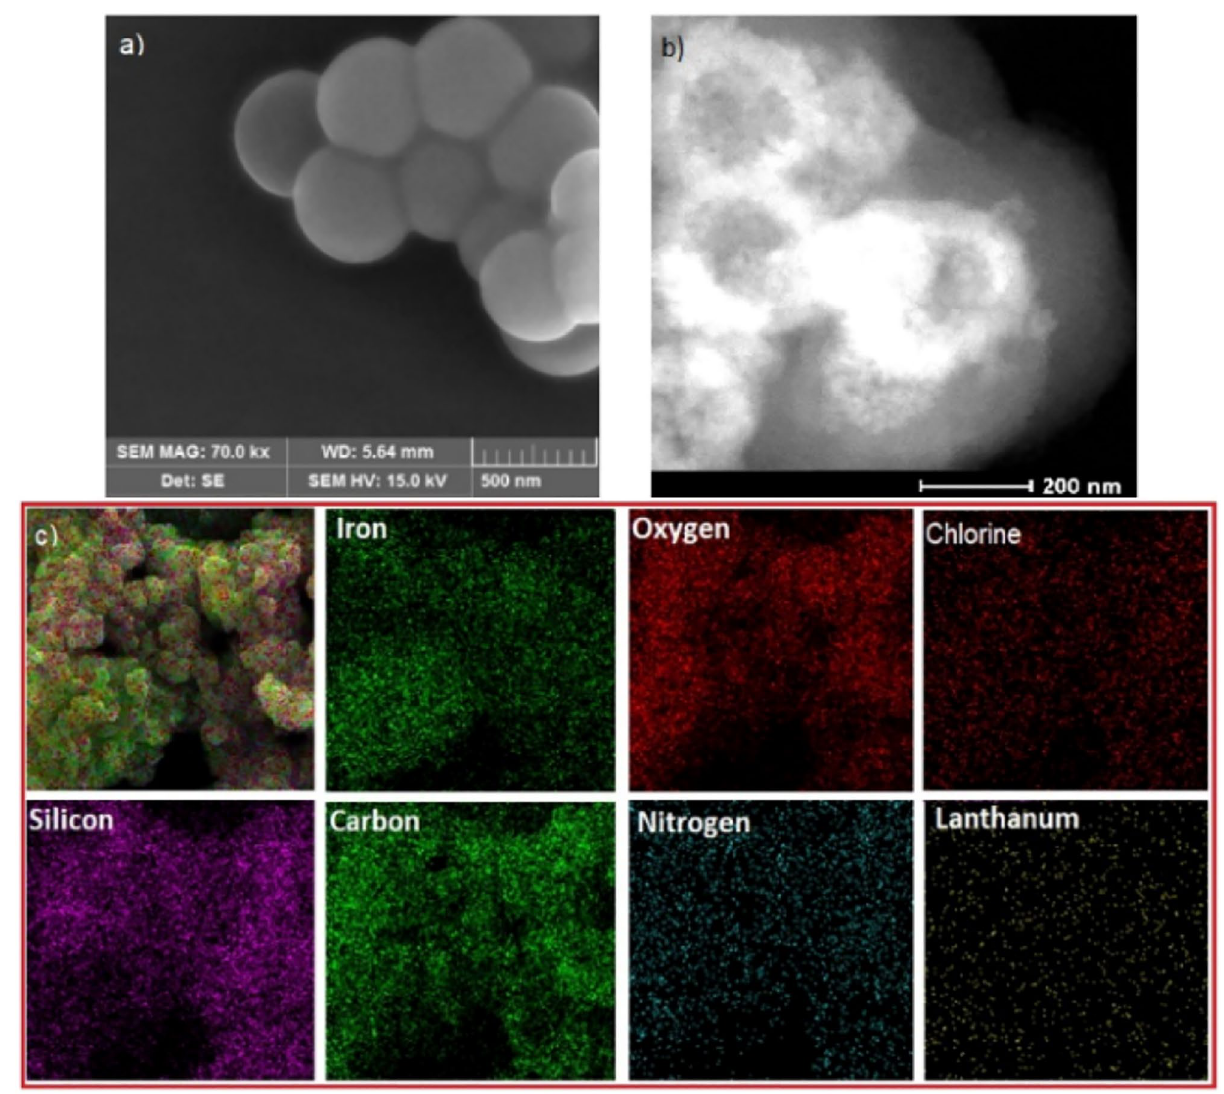
Figure 3. ( a ) SEM image (scale bar 500 nm), ( b ) TEM image (scale bar 200 nm), and ( c ) Energy dispersive X-ray spectroscopy (EDS) elemental maps for